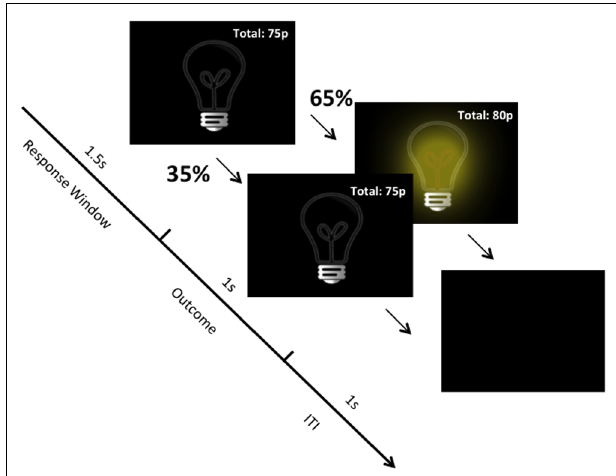
FIGURE 1 |Task structure. Example from the “High Density/Gain” block. Independent of responding, on 65% of trials the light bulb illuminates and on 35% it does not illuminate. On trials where the light bulb illuminates, 5p is added to subjects’ total